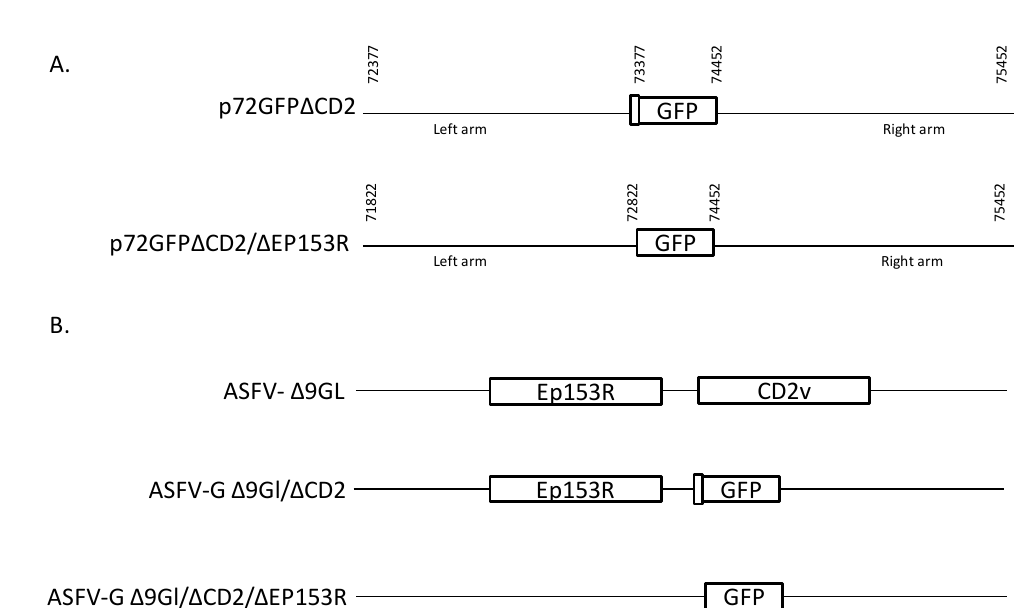
Figure 1. Schematic for the development of ASFV-G- Δ 9GL/ Δ CD2v and ASFV-G- Δ 9GL/ Δ CD2v/ Δ EP153R. ( A ) The transfer vectors contain the p72 promoter and a GFP cassette with flanking arms. As indicated transfer vector p72GFP ∆ CD2 has a residual 9 nucleotides of CD2 before the GFP indicated by the empty box; the flanking left and right arms positions are indicated and were designed to have flanking ends to both sides of the deletion/insertion cassette. ( B ) The resulting recombinants ASFV-G- Δ 9GL/ Δ CD2v and ASFV-G- Δ 9GL/ Δ CD2v/ Δ EP153R with the cassette inserted are shown on the bottom.